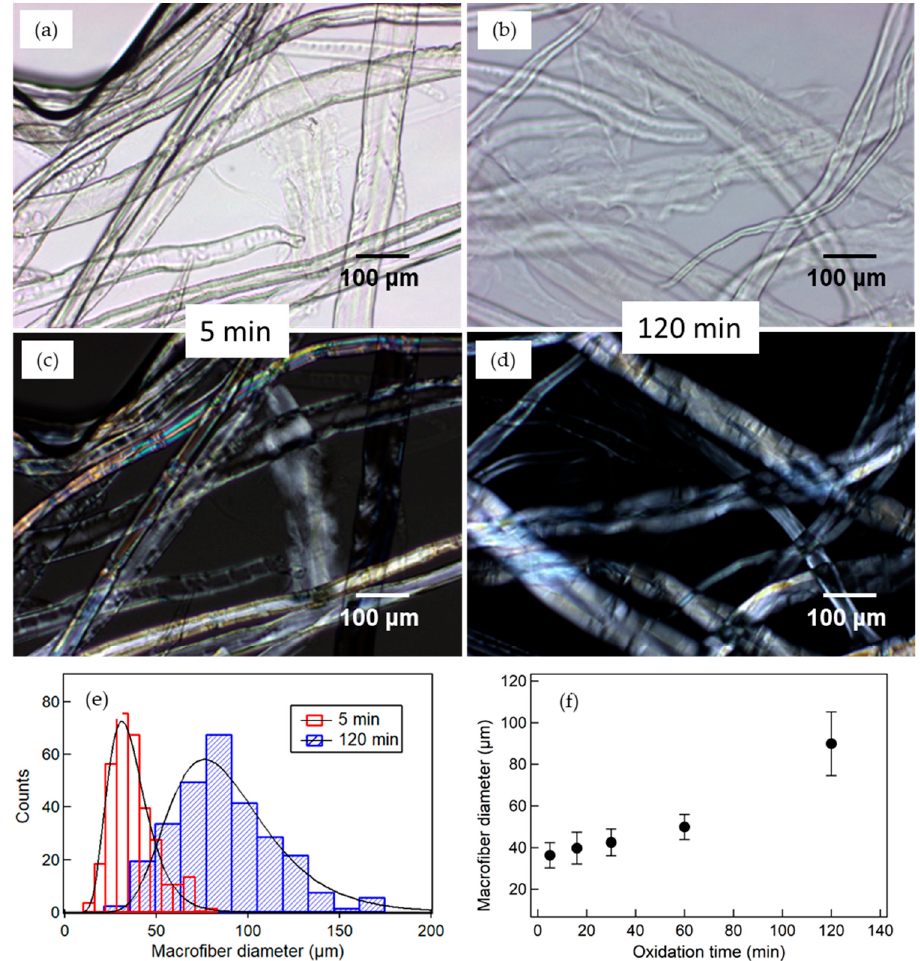
Figure 1. Bright field ( a , b ) and cross-polarized ( c , d ) optical micrographs of cellulose fibers after 5 min ( a , c ) and 120 min ( b , d ) of TEMPO-assisted oxidation reaction. Micrographs show fiber swelling upon oxidation. Cross-polarized micrographs show structural features smearing at longer times. ( e ) The histogram diameter distribution of 5- and 120-min specimens, and the best fits using the log-normal distribution function. The 5-min distribution is narrower and centered around 30 μ m, while the 120 min is broader and centered around 80 μ m. ( f ) The mean diameters of macrofibers as a function of oxidation time.